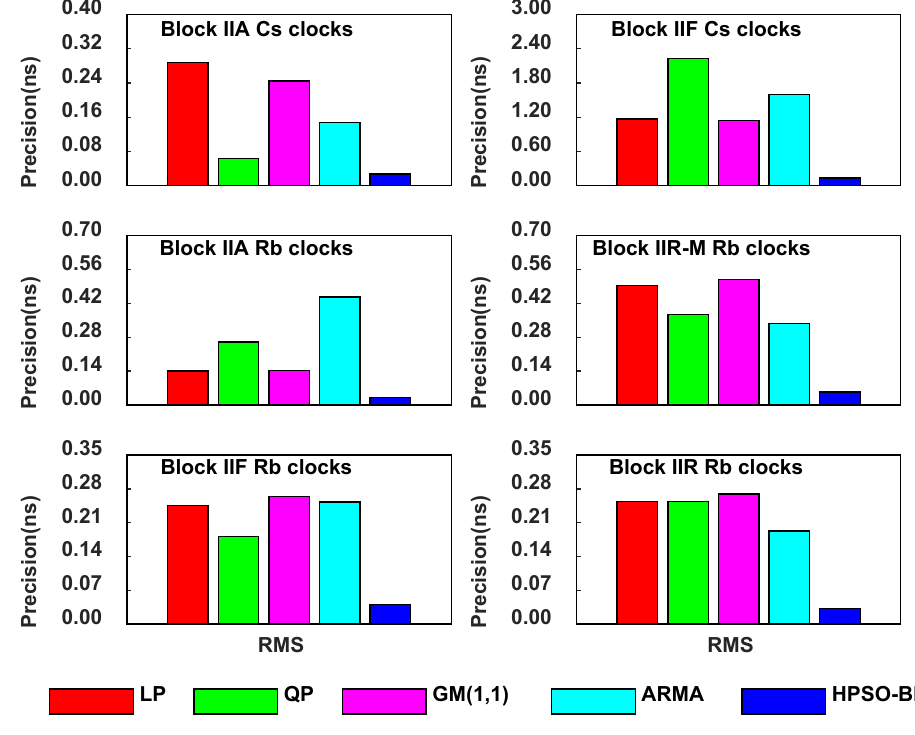
Figure 3. Prediction precision bar chart for six types of satellite clocks in 20 min for 24 March 2021.